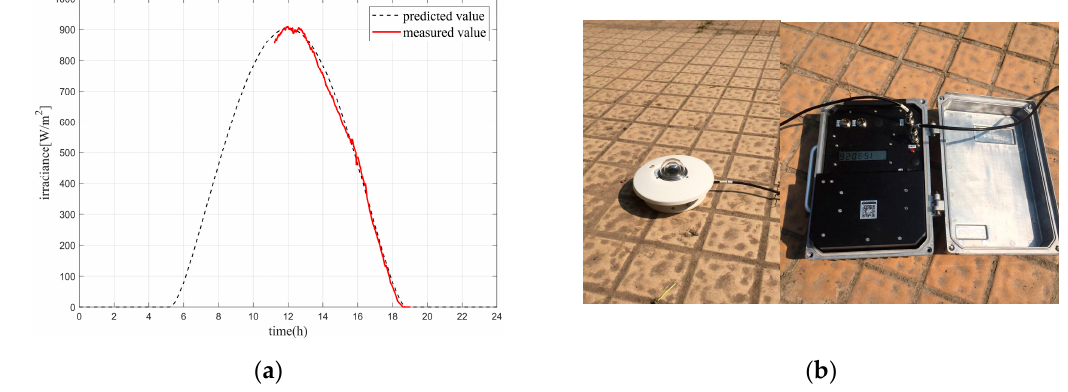
Figure 2. ( a ) Comparison of predicted and measured values of solar irradiance on 27 May 2017, Xi’an, China (34°16’ N 108°54’ E). ( b ) Measuring instrument of solar irradiance.